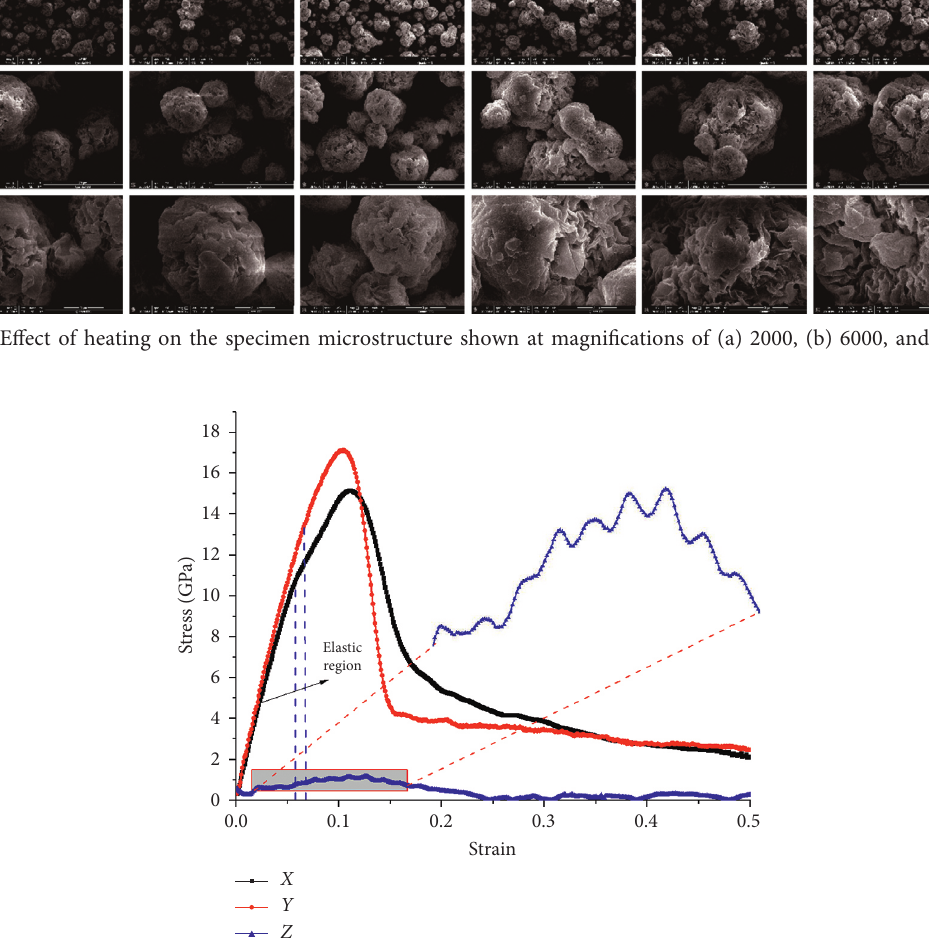
Figure 6: Stress-strain curve for Na-MMT at 300K. Table 1: Simulated and experimental Young’s modulus for dry